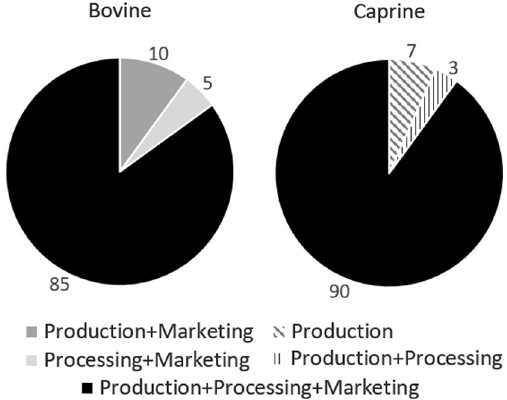
Fig. 3 Percentage of women involved in each of the two value chains’